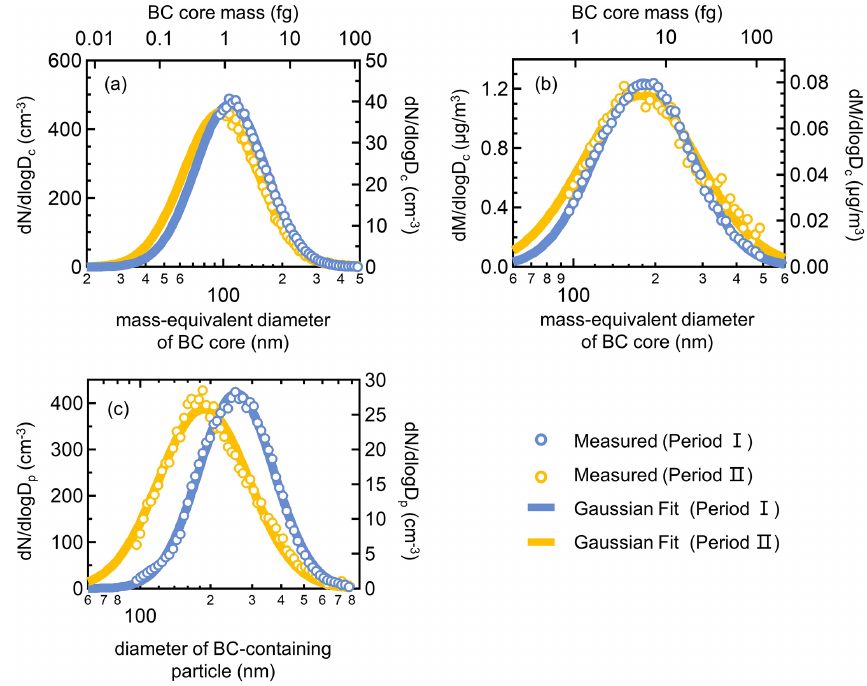
Figure 4. (a) Number and (b) mass size distribution of BC cores. (c) Number size distribution of whole BC-containing particles. The left axis corresponds to the values in Period I, and the right axis corresponds to the values in Period II. The mass-equivalent diameters of BC cores are obtained by assuming a density of 1.8gcm − 3